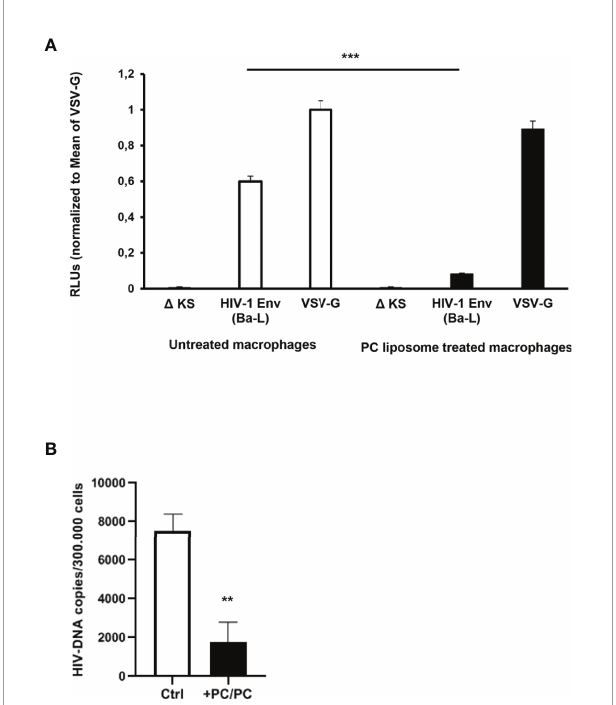
FIGURE 3 | Down-modulation of CD4 expression in PC liposomes pre-treated macrophages reduces HIV-1 entry. (A) Macrophages (5 × 10 5 cells/ml) were pre-treated or not with PC liposomes for 18 h at the ratio 1:1 (liposome:cell), washed and then infected with HIV-1 Env (Ba-L)- or VSV-G-pseudotyped luciferase-encoding HIV-1. After infection, cells were washed, cultured for 6 days, and infection was quanti fi ed by luciferase activity. RLUs were normalized to the value for luciferase obtained in the VSV-G-pseudotyped virus-infected cells. Mean relative luciferase activities ± SD are shown (three independent experiments performed in quadruplicate on cells from three different healthy donors; ***p <0.0001 by Student ’ s t -test). A nonfunctional envelope (HIV-1- D KS) was used as a negative control to determine the background levels of luciferase activity. (B) Type-1 macrophages (3 × 10 5 cells/ml) were pre-treated or not with PC liposomes for 18 h at the ratio 1:1 (liposome:cell), washed and then infected with replication competent R5 HIV-1 81A strain. After infection, cells were washed, cultured for 4 days, and intracellular HIV-DNA was quanti fi ed by ddPCR. Total amount of HIV-DNA was normalized on cell number obtained by the quanti fi cation of Albumin. Results are shown as mean HIV-DNA values ± SD of the values obtained from 4 replicates and are representative of experiments performed on cells from two healthy donors (**p = 0.0005 by Student ’ s t